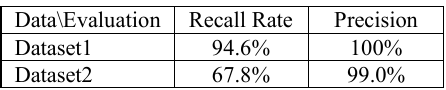
Table. 2 Object-level quantitative evaluation of fallen and standing dead trees, the dataset1 shows the result of standing